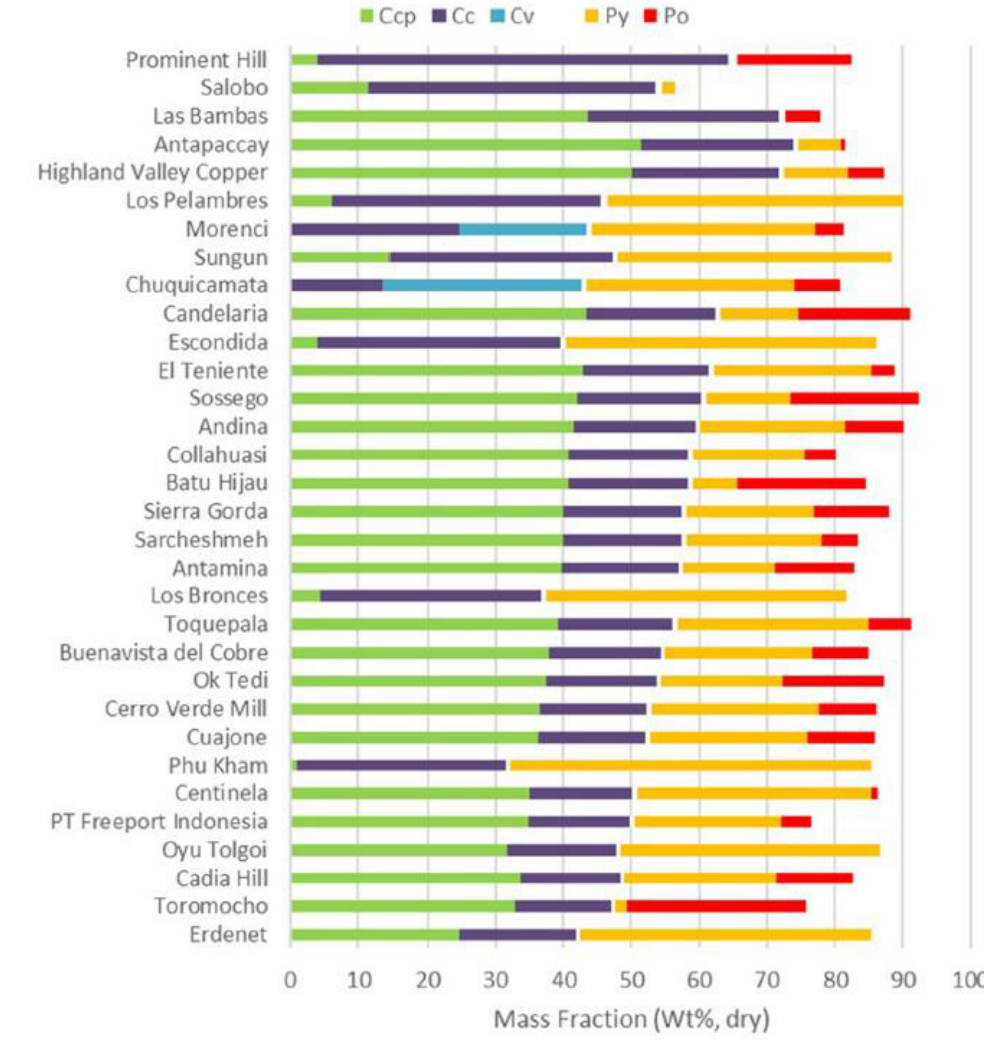
Figure 5. Mineralogical composition of copper concentrates from the world’s leading copper pro- ducers. Ccp, Cc, Cv, Py, and Po are chalcopyrite, chalcocite, covellite, pyrite, and pyrrhotite, respec- tively [77]. Table 4. Mineralogical composition of concentrates from Chuquicamata mine (% v/v, relative to the total sulfide phase) [52].